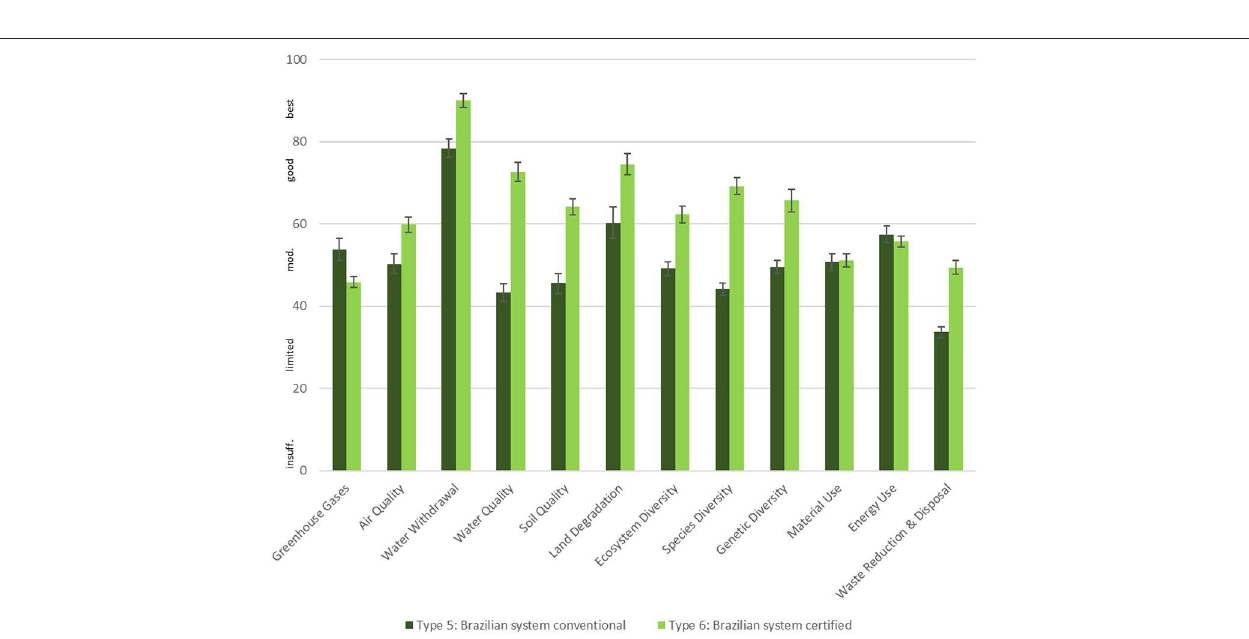
FIGURE 2 | Sustainability performance of typical Ethiopian coffee production systems in “Environmental Integrity”.